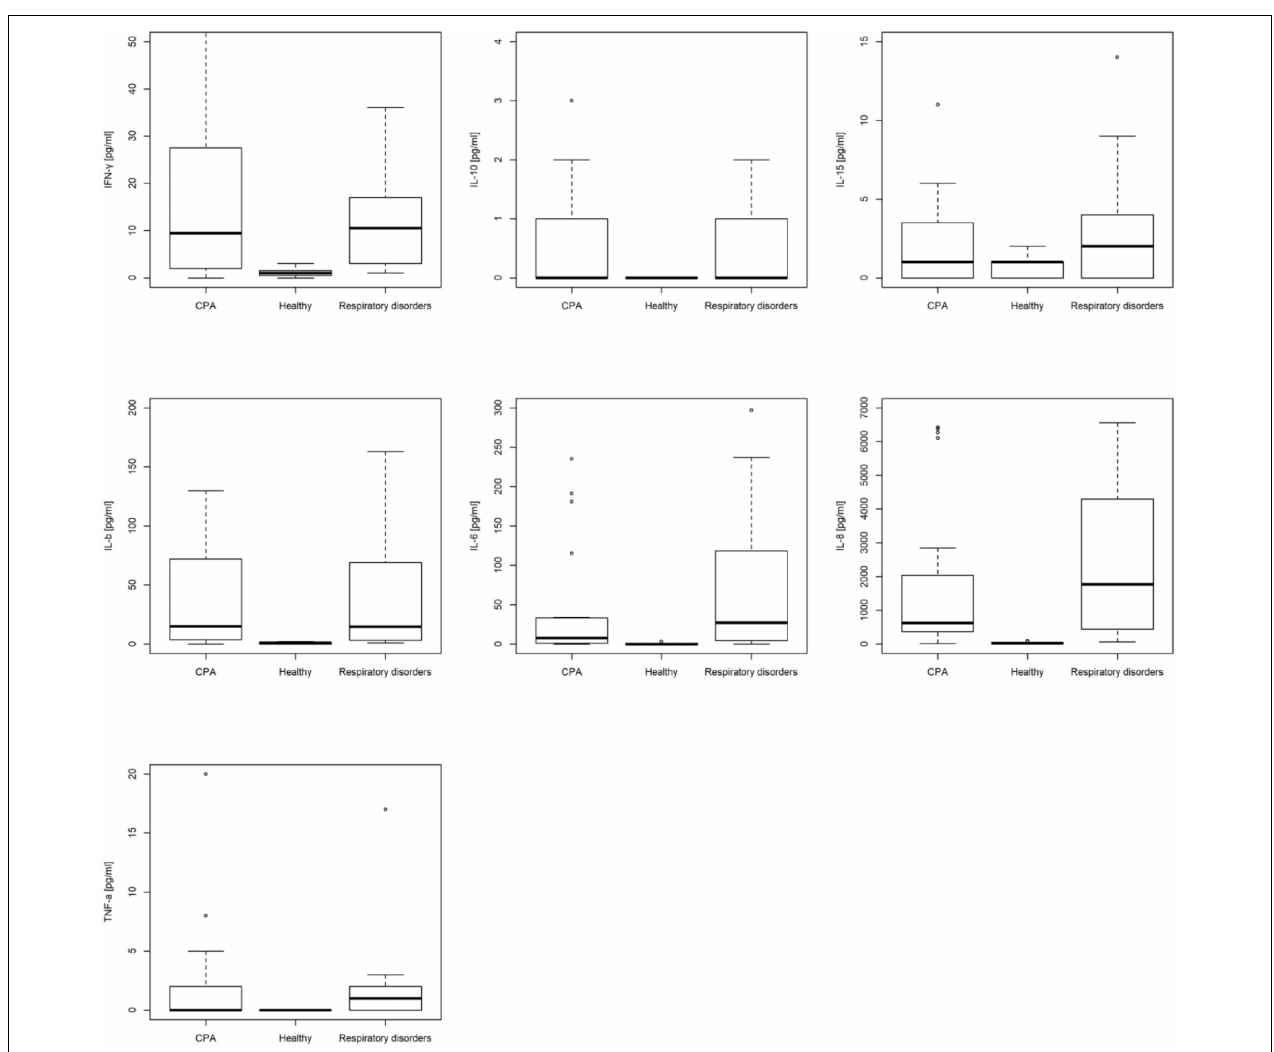
FIGURE 4 | Box plots of bronchoalveolar lavage fluid (BALF) interleukin (IL)-1 β , IL-6, IL-8, IL-10, IL-15, interferon- γ , and tumor necrosis factor (TNF)- α in patients with chronic pulmonary aspergillosis (CPA), patients with respiratory disorders without CPA and healthy